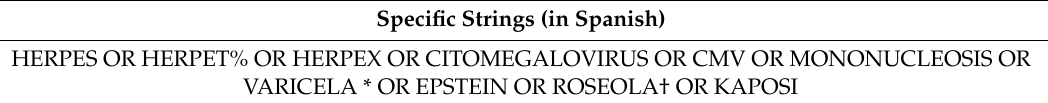
Table A3. Text mining search strategies. Specific Strings (in